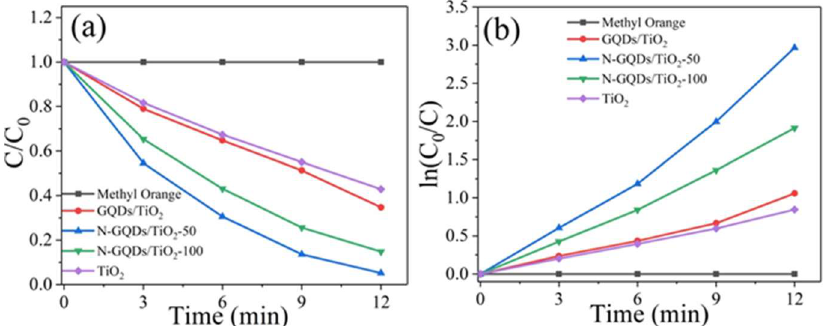
Figure 6. ( a ) The relationship between the concentration of undegraded MO and illumination time for different photocatalysts. ( b ) The relationship between the logarithm of C/C 0 and irradiation time of different photocatalysts. Table 2. The content (%) of doped-N and the different N species of N-GQDs-50 and N-GQDs-100. Samples N (at%) Pyridinic N (at%) Pyrrolic N (at%) Graphitic N